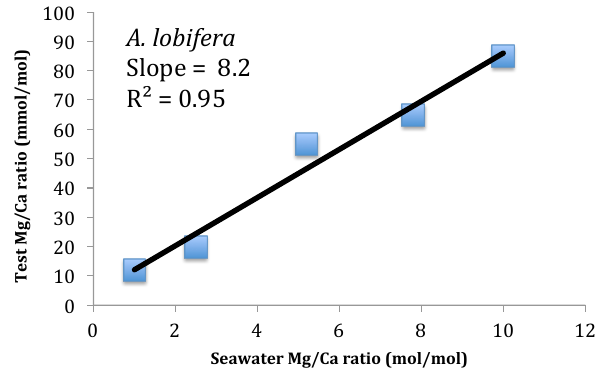
Fig. 4. The relationship between ambient seawater Mg/Ca and Figure 4: The relationship between ambient seawater Mg/Ca and Mg/Ca ratio in the test of A. 279 Mg/Ca ratio in the test of A. lobifera (average data adopted from lobifera (average data adopted from Segev and Erez, 2006). For these data, the TMT model 280 Segev and Erez, 2006). For these data, the TMT model predicts a slope of 10 × PT ≈ 11, which is within about 25% of the ob- predicts a slope of 10*PT ≈ 11, which is within about 25% from the observed value. (Data for A. 281 served value. (Data for A. lessonii in Segev and Erez (2006) were lessonii in Segev and Erez, (2006) were not included because values for test Mg/Ca obtained at 282 not included because values for test Mg/Ca obtained at normal sea- water Mg/Ca differ dramatically from those obtained by Raja et normal seawater Mg/Ca differ dramatically from those obtained by Raja et al . (2005) on the same 283 al. (2005) for the same species.) 284